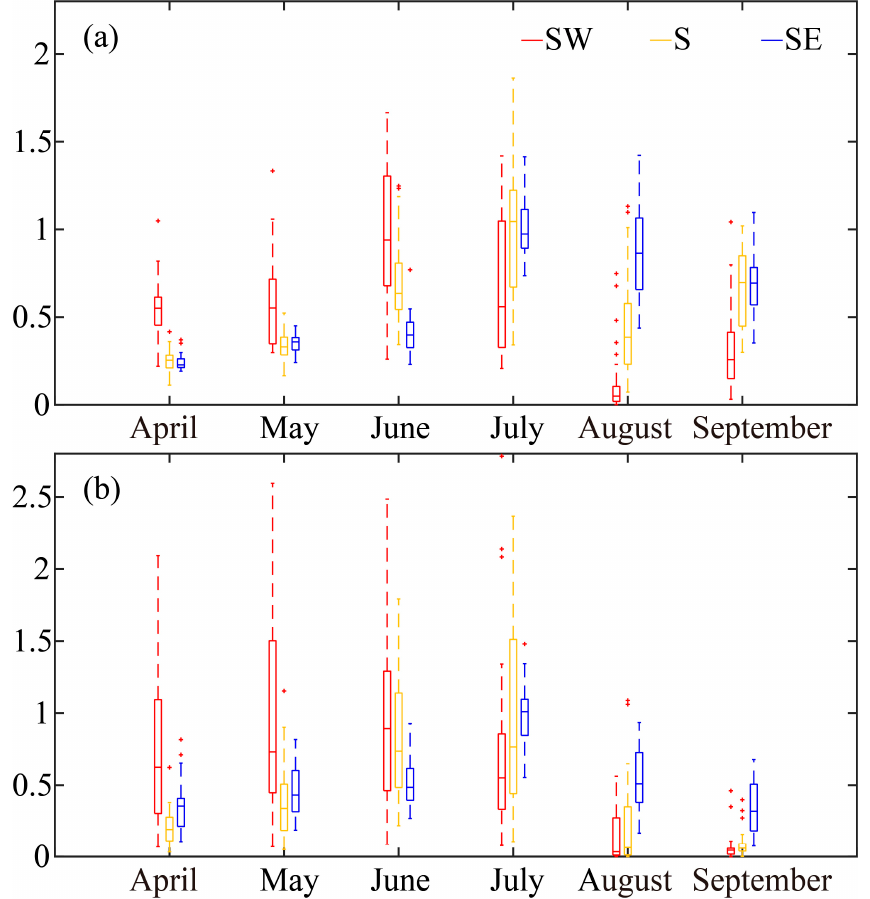
Figure 8. Box-whispers of the normalized evaporative sources for three groups of featured sub-regions (southwest area (SW), south area (S) and southeast area (SE)) from April to September over 1982–2011 for ( a ) the SETP and ( b ) the MYRB.